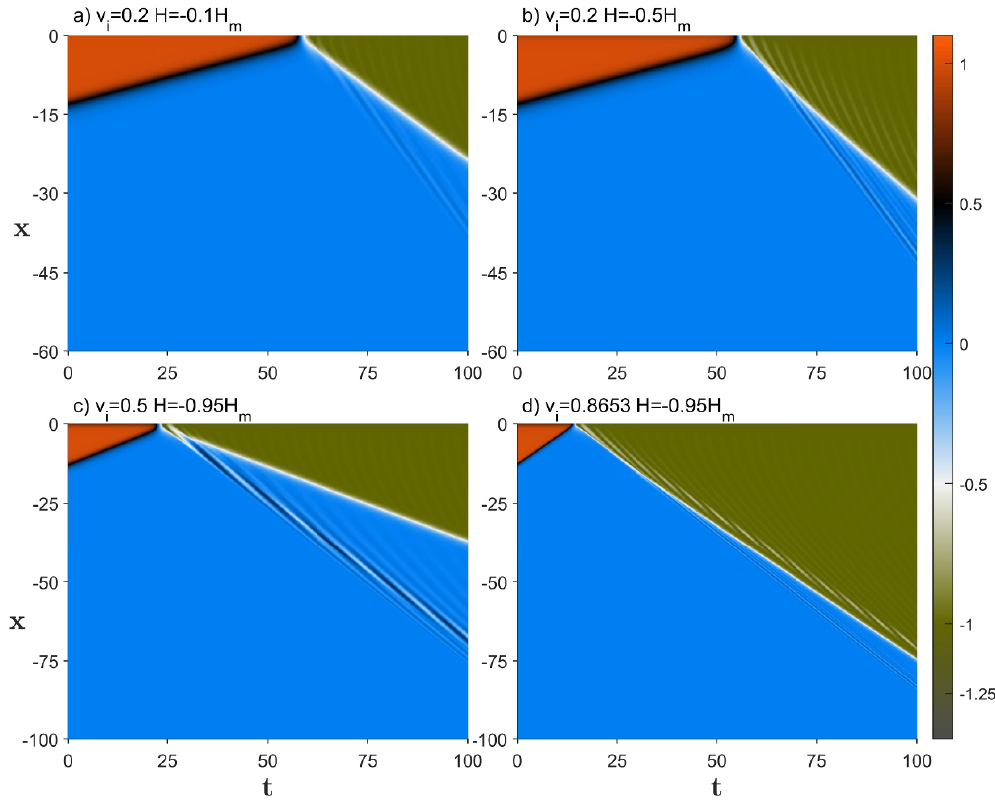
Figure 18 . Φ 1+ kink scattering with ˜ φ 1 boundary for different values of v i and H , showing: in a) and b), the changing of the topological sector with a produced Φ 1 − antikink; in c) and d), a produced oscillon and Φ 1 −